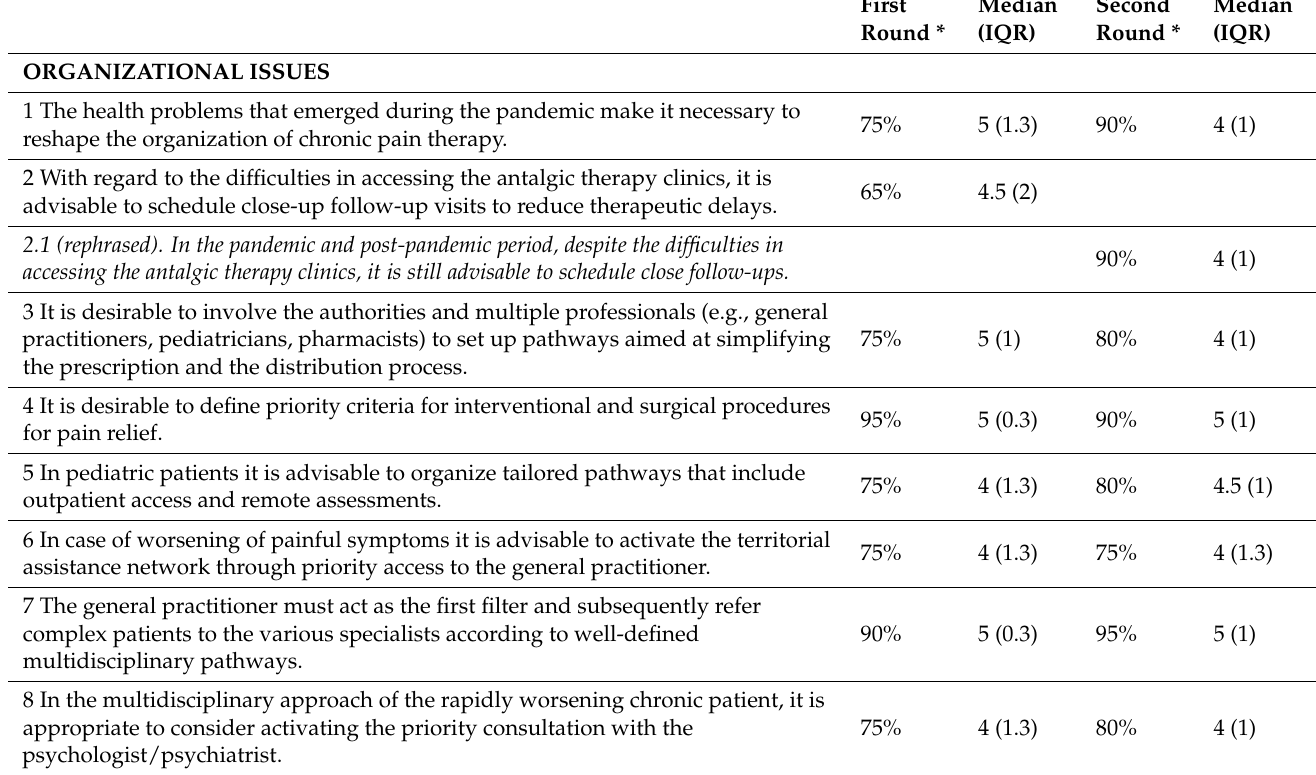
Table 3. Comparative judgments in the first and second Delphi